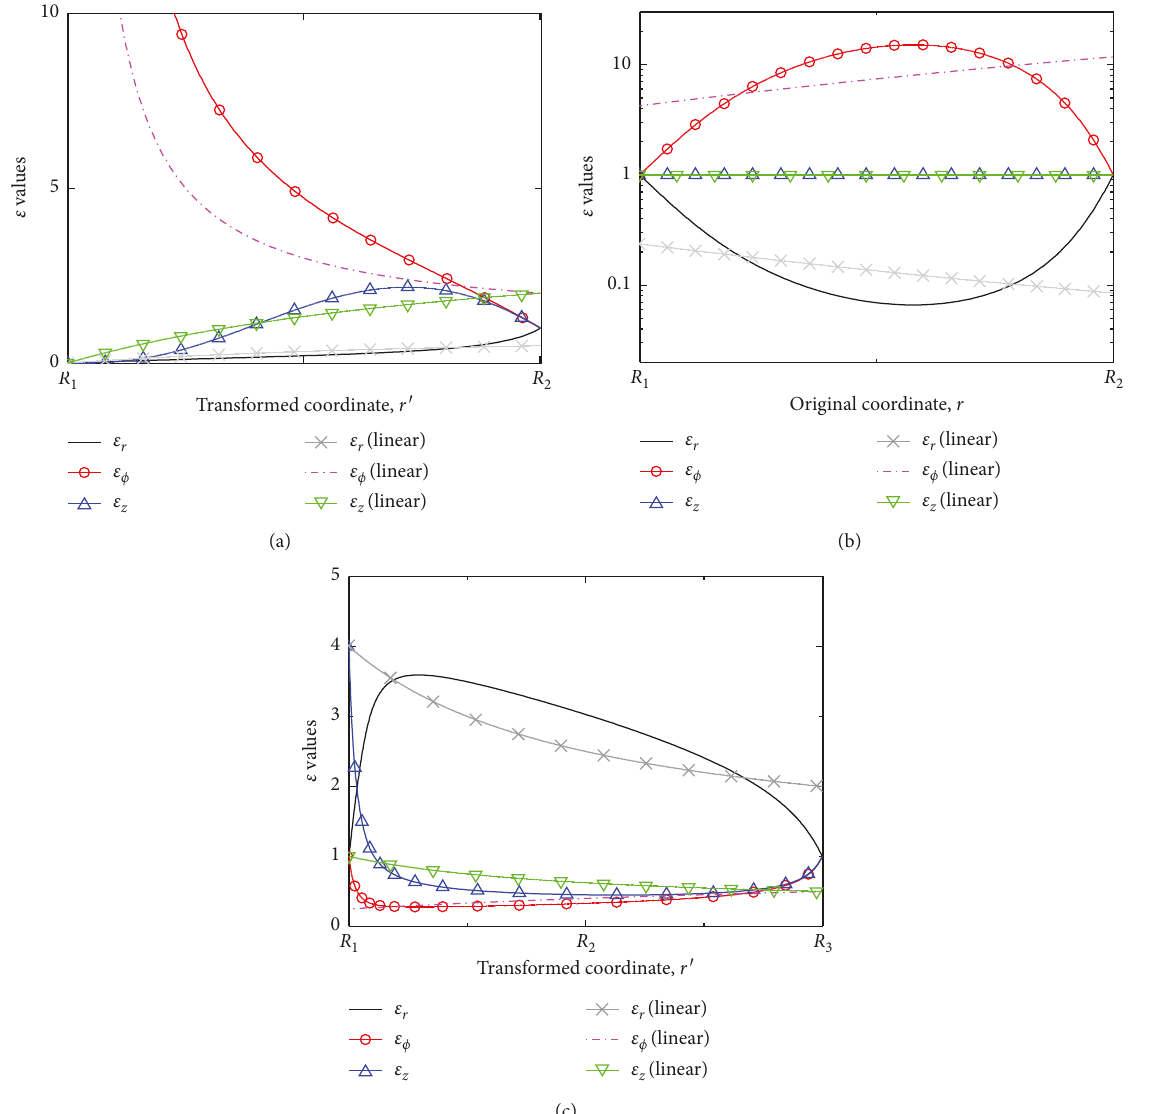
Figure 3: Metamaterial parameters: (a) the cloak, (b) the rotator, and (c) the